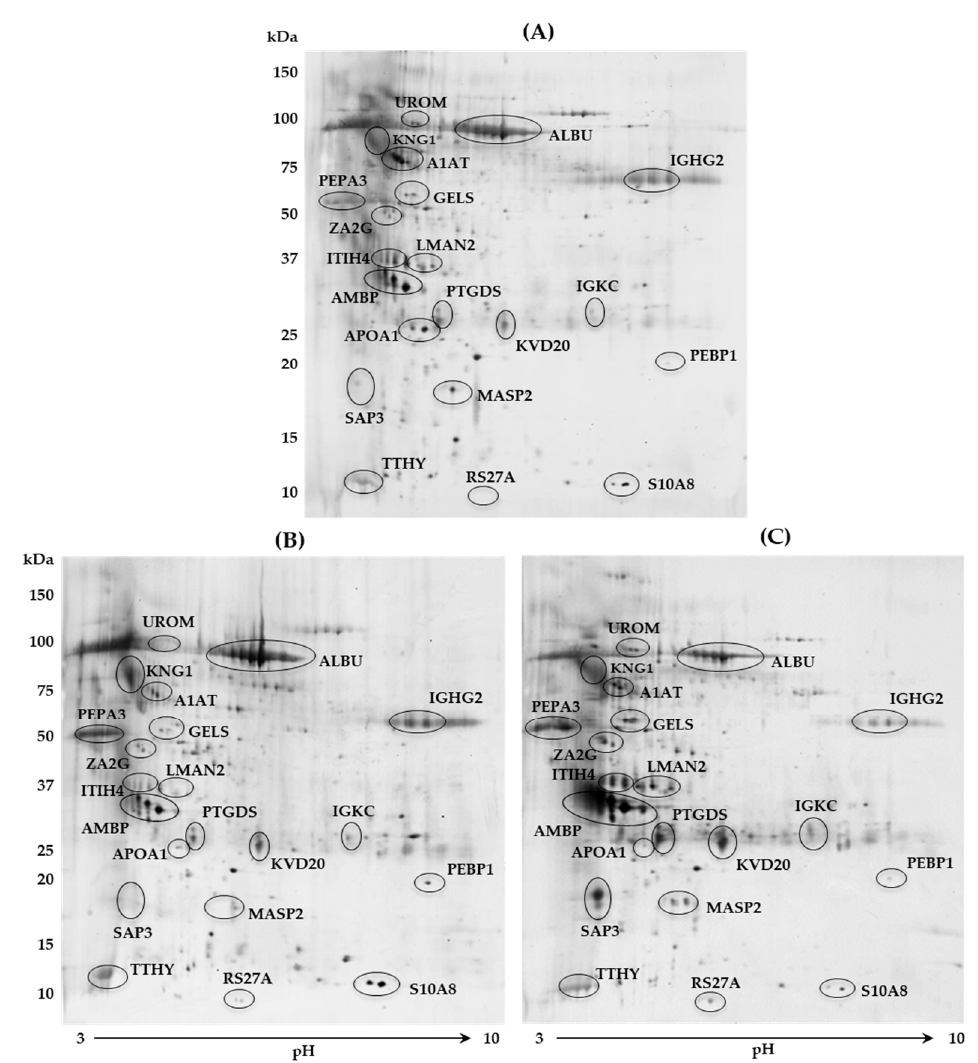
Figure 2. Representative 2DE urinary maps. The differentially expressed protein spots among ( A ) control group, ( B ) menstrually related migraine group, and ( C ) post-menopause migraine group are evidenced by ellipses; protein entry names refer to those reported in Table 2. Two-dimensional separation was performed by 17 cm IPG strip, pH range 3–10 (first-dimension), and 8–16% polyacrylamide gradient gel (second-dimension). Molecular weight marker (PrecisionPlus All Blue, Bio-Rad) is expressed in kilodalton (kDa).